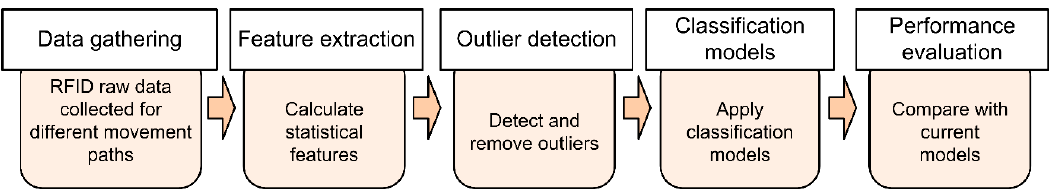
Figure 1. Radio frequency identification (RFID) readings based on classification models.